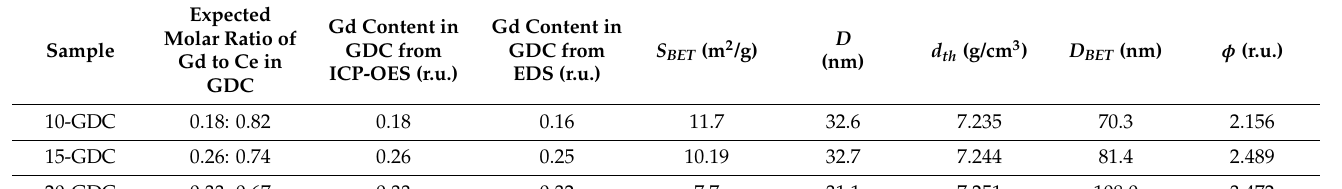
Table 1. The summary of the elemental analysis results and the physical properties of the GDC ceramic powders, calcined at 900 °C.